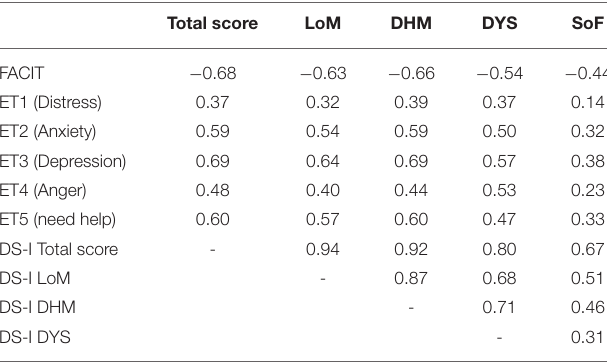
TABLE 6 | Correlations between DS-I, FACIT-fatigue and ET subscales, as well as intercorrelations of DS-I (sub-)